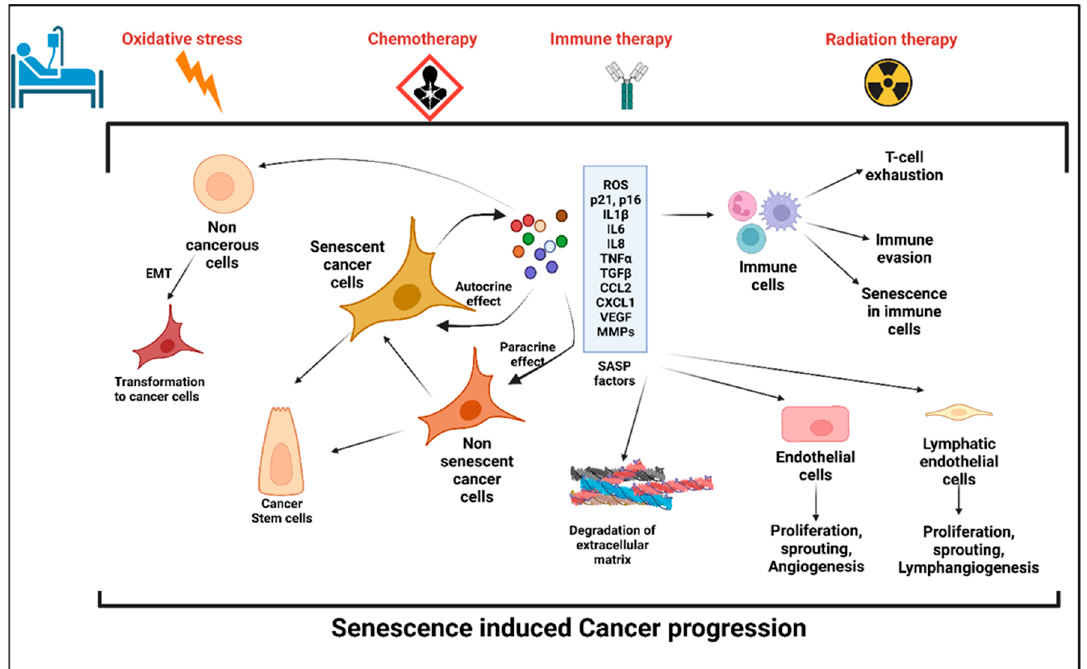
Figure 1. Stress-induced senescence, SASP, and cancer progression. Anticancer therapy including chemotherapy, radiation therapy, and immune therapy induced premature senescence in cancer cells and the cells in the tumor microenvironment (TME). Senescent cancer cells secrete plethora of proinflammatory cytokines, chemokines, matrix metalloproteinases, angiogenic factors, and reactive oxygen species, which are collectively known as senescence-associated secretory phenotype (SASP). SASP factors induce senescence in the cells in the TME, which in turn evade the immune response. Factors secreted by senescent cells promote angiogenesis and lymphangiogenesis by its effects on neighboring endothelial cells and hence enhances cancer cell metastasis. SASP-induced cancer stemness increases the proliferation and self-renewal properties of the cancer cells.